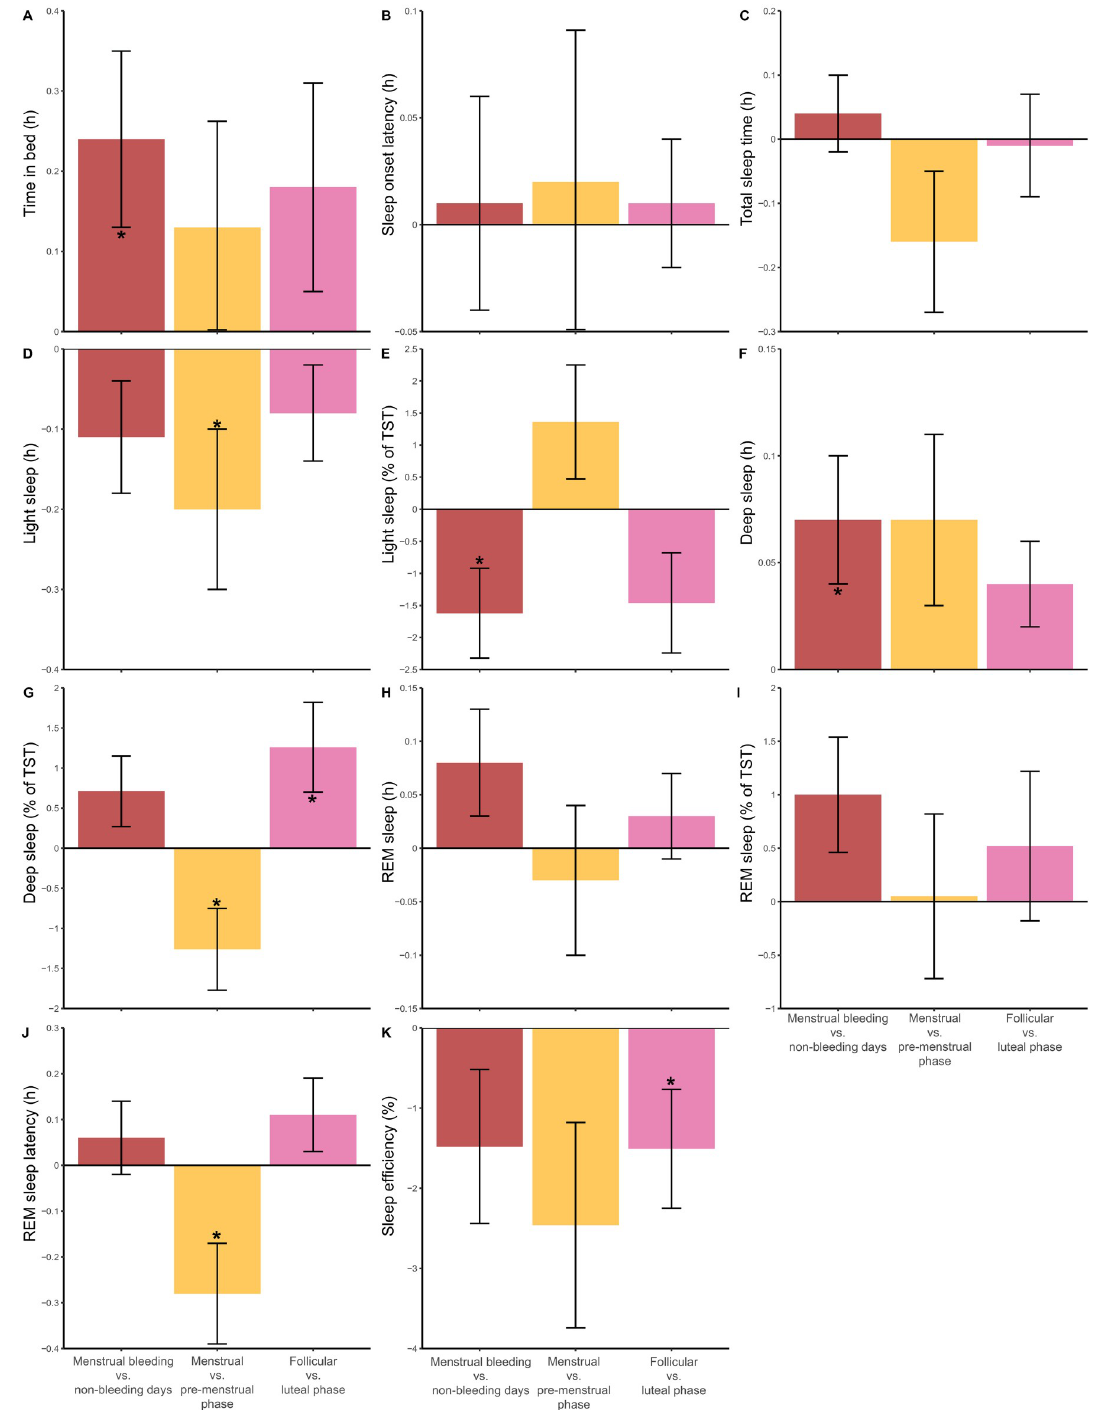
Fig 2. Within-athlete variations in sleep variables across different phases of the menstrual cycle. The measured variables included time in bed (A), sleep onset latency (B), total sleep time (C), light sleep in h (D) and % (E), deep sleep in h (F) and % (G), rapid eye movement (REM) sleep in h (H) and % (I), REM latency (J) and sleep efficiency (K), and spanned the following periods: menstrual bleeding vs. non-bleeding days (red bars), menstrual vs. pre-menstrual phase (yellow bars), and follicular vs. luteal phase (pink bars). Data are based on sleep monitoring in 15 female endurance athletes. The error bars represent the S.E.; � represents a significant change, p < .05.